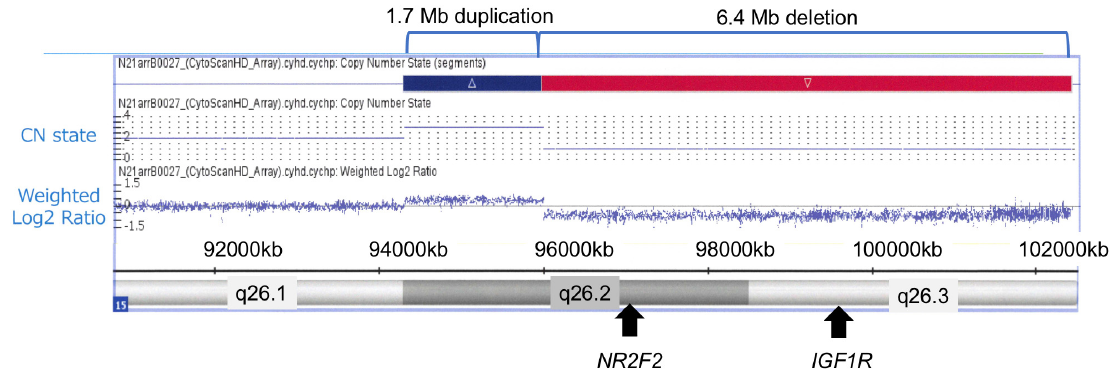
Figure 1. The result of fluorescent in situ hybridization (FISH) analysis of the peripheral blood sample.